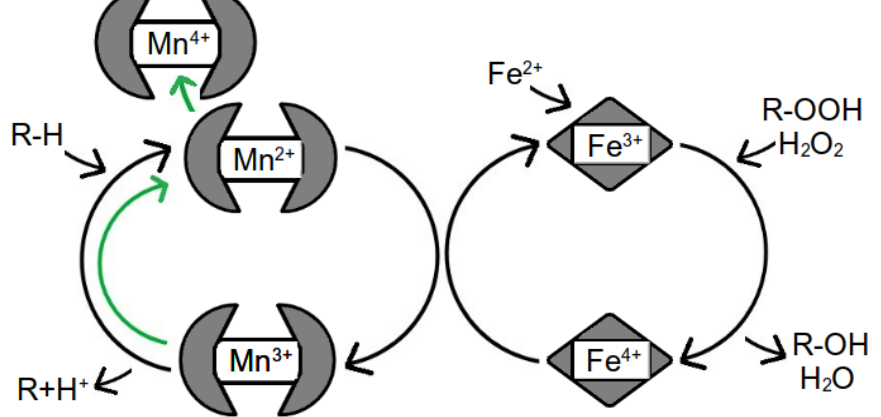
Figure 9. Schematic of possible enzymatic manganese cycling in the presence of detrital organic matter. The green arrow represents a potential pathway of an oxidase that forms Mn 4+ complexes (adapted from [112]).